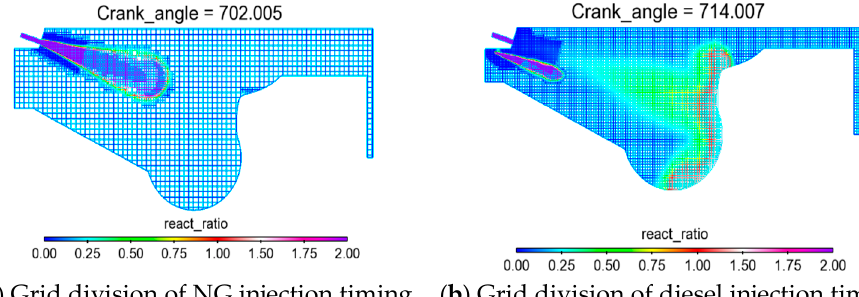
Figure 1. Grid division of natural gas (NG) ( a ) and diesel ( b ) injection timing in the combustion chamber. Table 2. Selection of sub-models for the CFD numerical simulation.